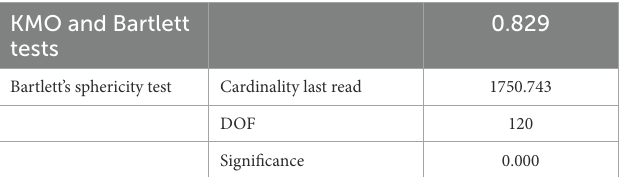
TABLE 5 Table of Bartlett’s sphericity test and KMO test for demand